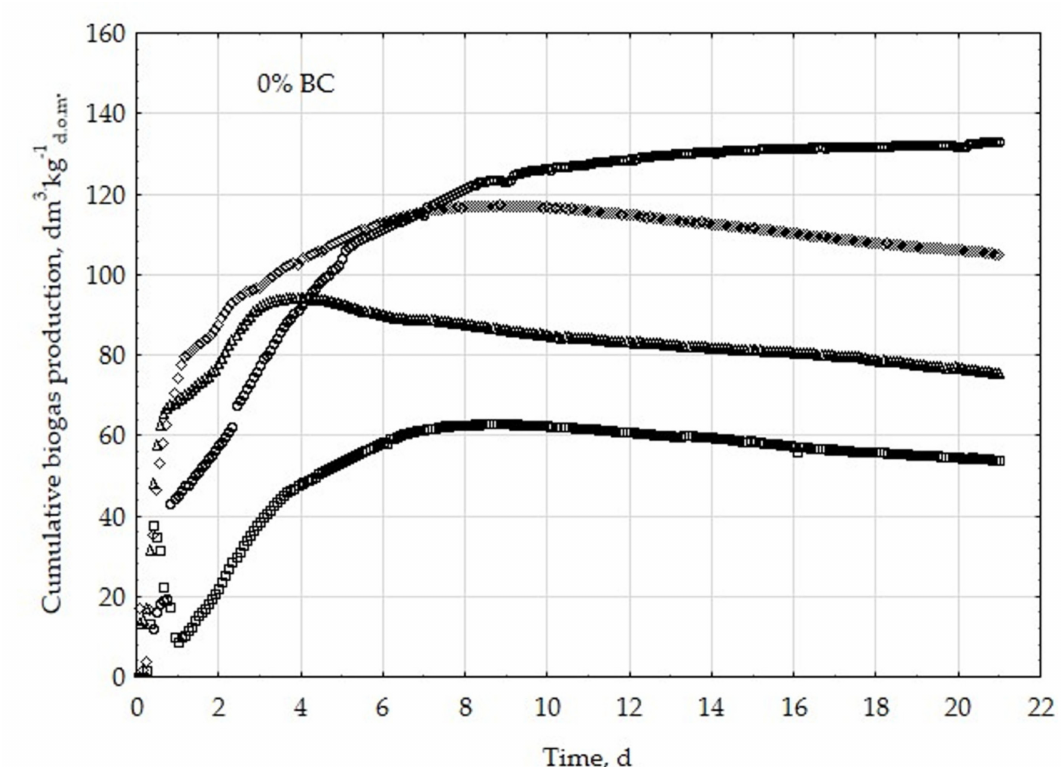
Figure A1. Biogas production from BSG: cumulative curves in variant with biochar addition at the level of 0%. The number of repetitions was four.